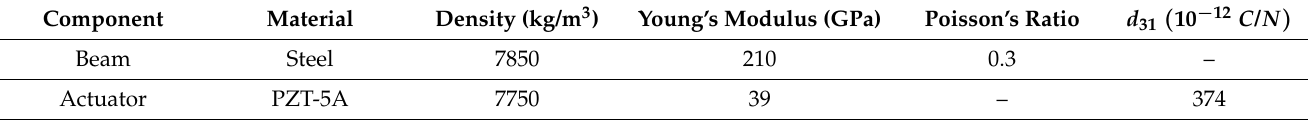
Table 3. Material details of the beam and PZT